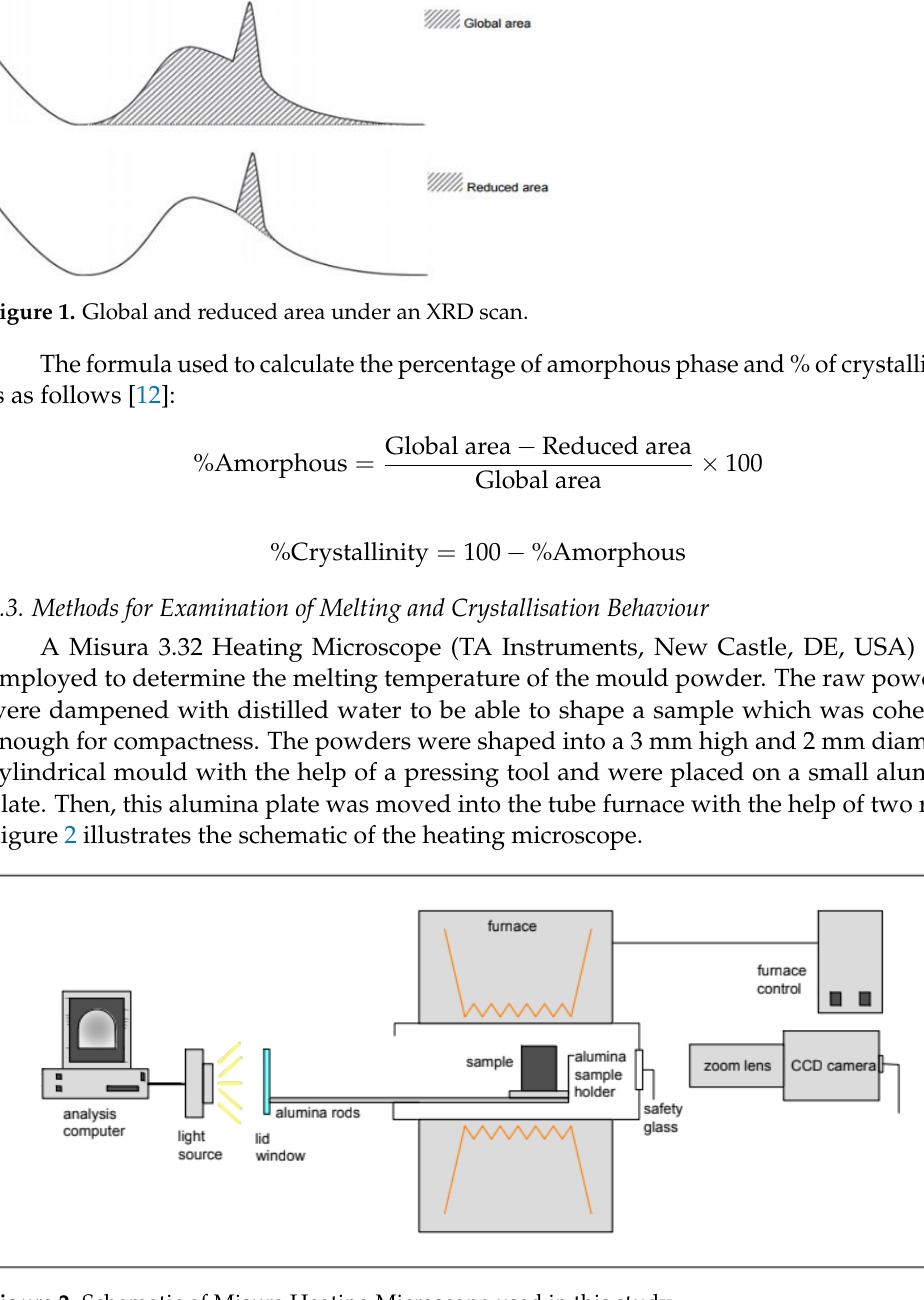
Figure 2. Schematic of Misura Heating Microscope used in this study.